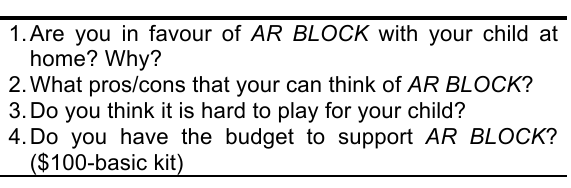
Figure 2. Rotating Colour Blocks to change a building’s